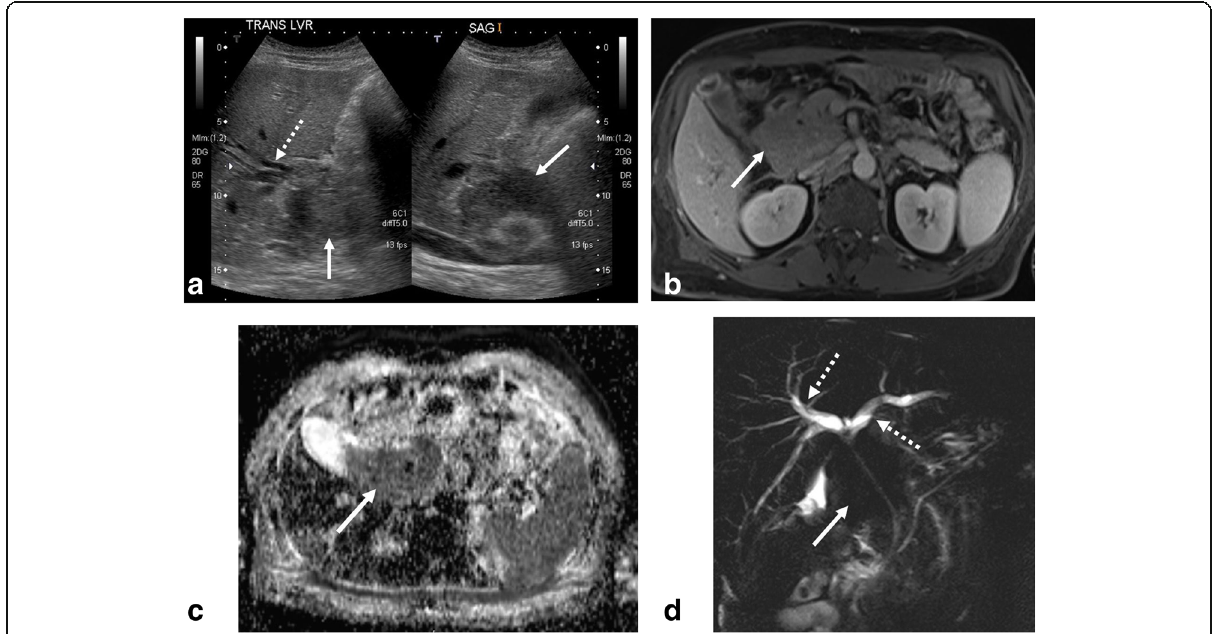
Fig. 4 Nodal mass with biliary obstruction. A 55-year-old male presenting with jaundice. a Initial grayscale transverse and sagittal ultrasound images demonstrate an ill-defined hypoechoic mass near the porta hepatis (solid arrow) with associated biliary dilatation. Follow-up MRI with ( b ) axial post contrast, ( c ) apparent diffusion coefficient map, and ( d ) coronal MRCP images demonstrate an enhancing mass with diffusion restriction (solid arrows) encasing and narrowing the extrahepatic bile ducts causing intrahepatic biliary dilatation (dashed